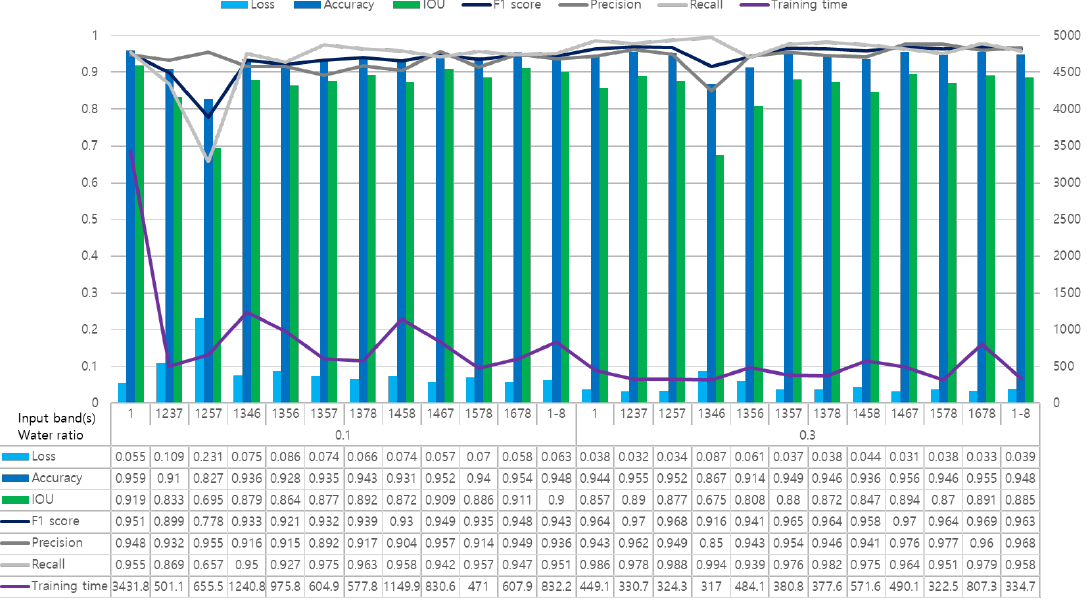
Figure 8. Accuracy of image segmentation by water ratio and combinations of input layers (numbers in the input band(s) column indicate band combinations of 1-VV, 2-DEM, 3-SL, 4-AS, 5-PC, 6-TWI, 7-BF, and